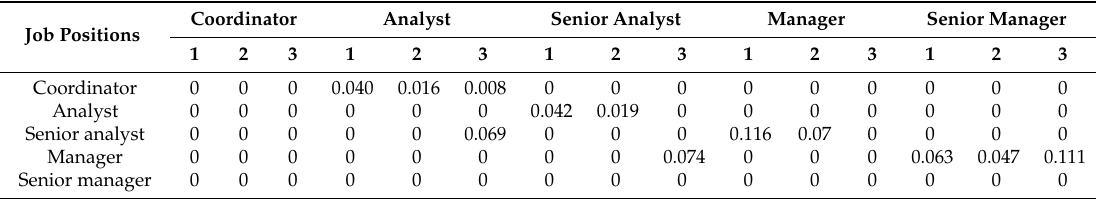
Table 10. The optimal solutions of advancement rates in three time